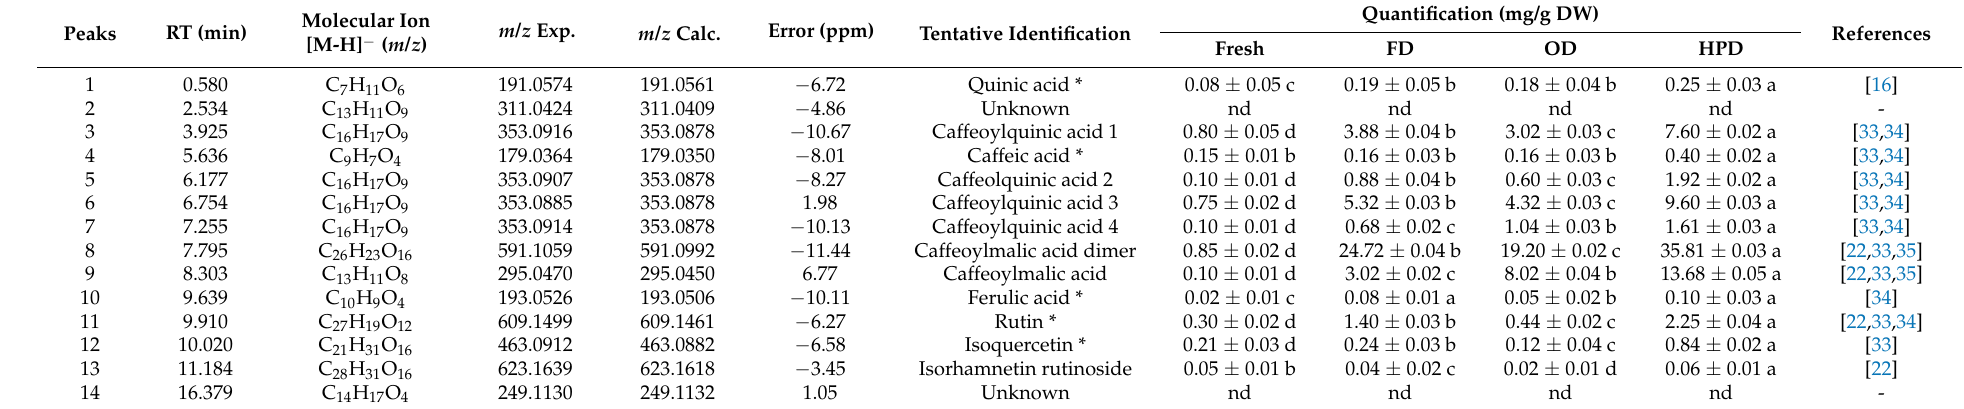
Table 1. High performance liquid chromatography/diode array detector/mass spectrometry-time-of-flight (HPLC/DAD/MS-TOF) tentative identification and quantification of the phenolic compounds extracted from fresh or dried leaves of U. dioica plants collected in the wild. Leaves were dried with different methods: freeze-drying (FD), oven-drying (OD) and heat pump drying